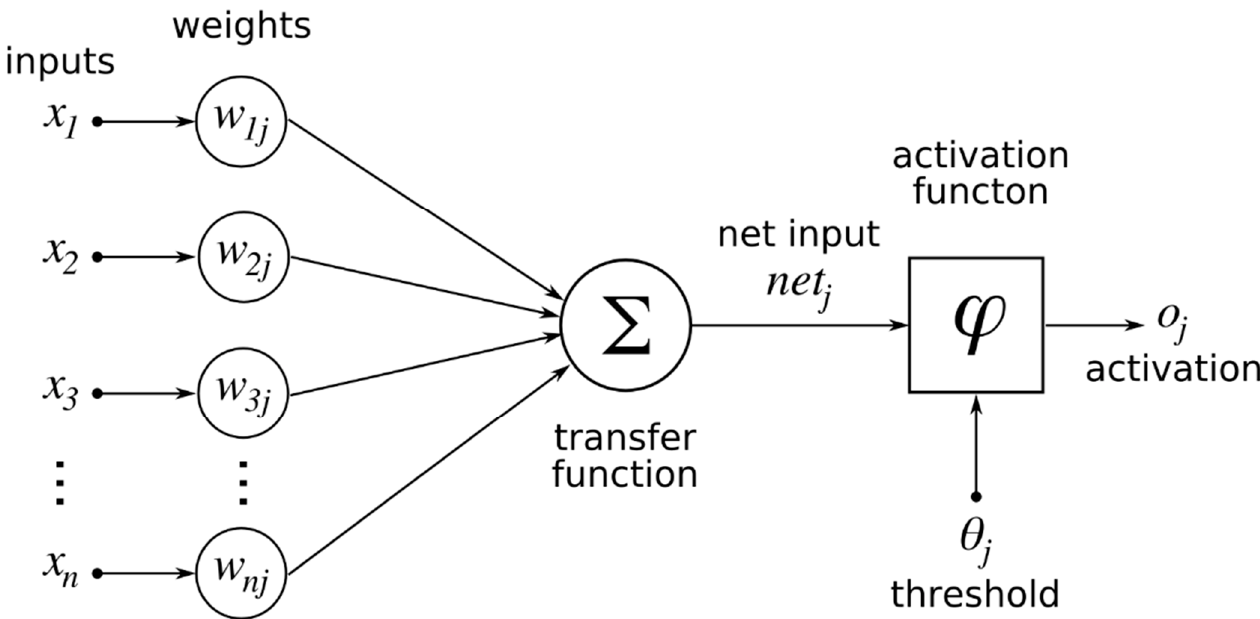
Figure 1. An artificial neuron [16].